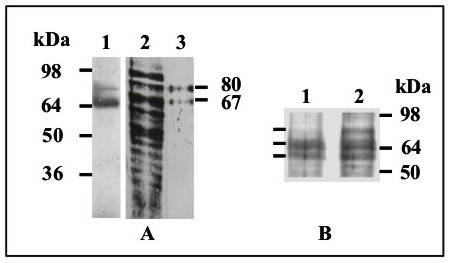
VOPBA and DENV2 affinity chromatography of the virus dengue receptors. Proteins from Aedes aegypti MGs were extracted with 0.05% Triton X-100, separated by 10% SDS-PAGE and blotted on to a PVDF membrane. The putative receptors were revealed after incubation with DEN2 virus and peroxidase-labeled goat anti-mouse antibody (panel A, lane 1) as described in the methods section. Receptors were purified from C6/36 cell membranes (panel A, lane 3) or MG (fractions 1 and 2, panel B) by DENV2 affinity chromatography using a DEN2-Sepharose™ 4B column as described in the methods section. The apparent molecular weights of these proteins are shown on the right side of panel A and on the left side of panel B. Proteins separated by SDS-PAGE were silver stained. The protein pattern of total C6/36 membranes is shown in panel A lane 2. Molecular weight markers are shown on the left side in panel A and on the right side in panel B.